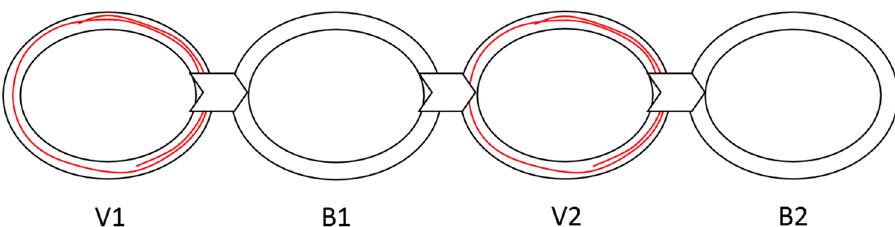
Figure 2. An illustration of the four segments of each trial. Two concentric black ellipses mark the target area on the phase plane, within which participants should maintain the cursor. During V1 and V2 (each lasting 10 sec), a red trace representing the forearm movement is displayed on the screen. During B1 and B2 (each lasting 20 sec), the trace of the movement is not displayed on the